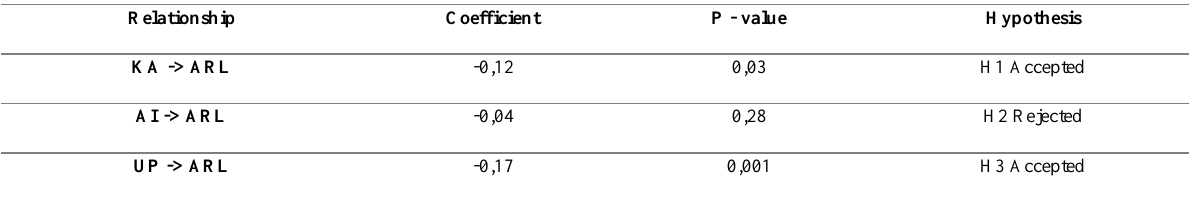
Table 1: Hypothesis Test 1